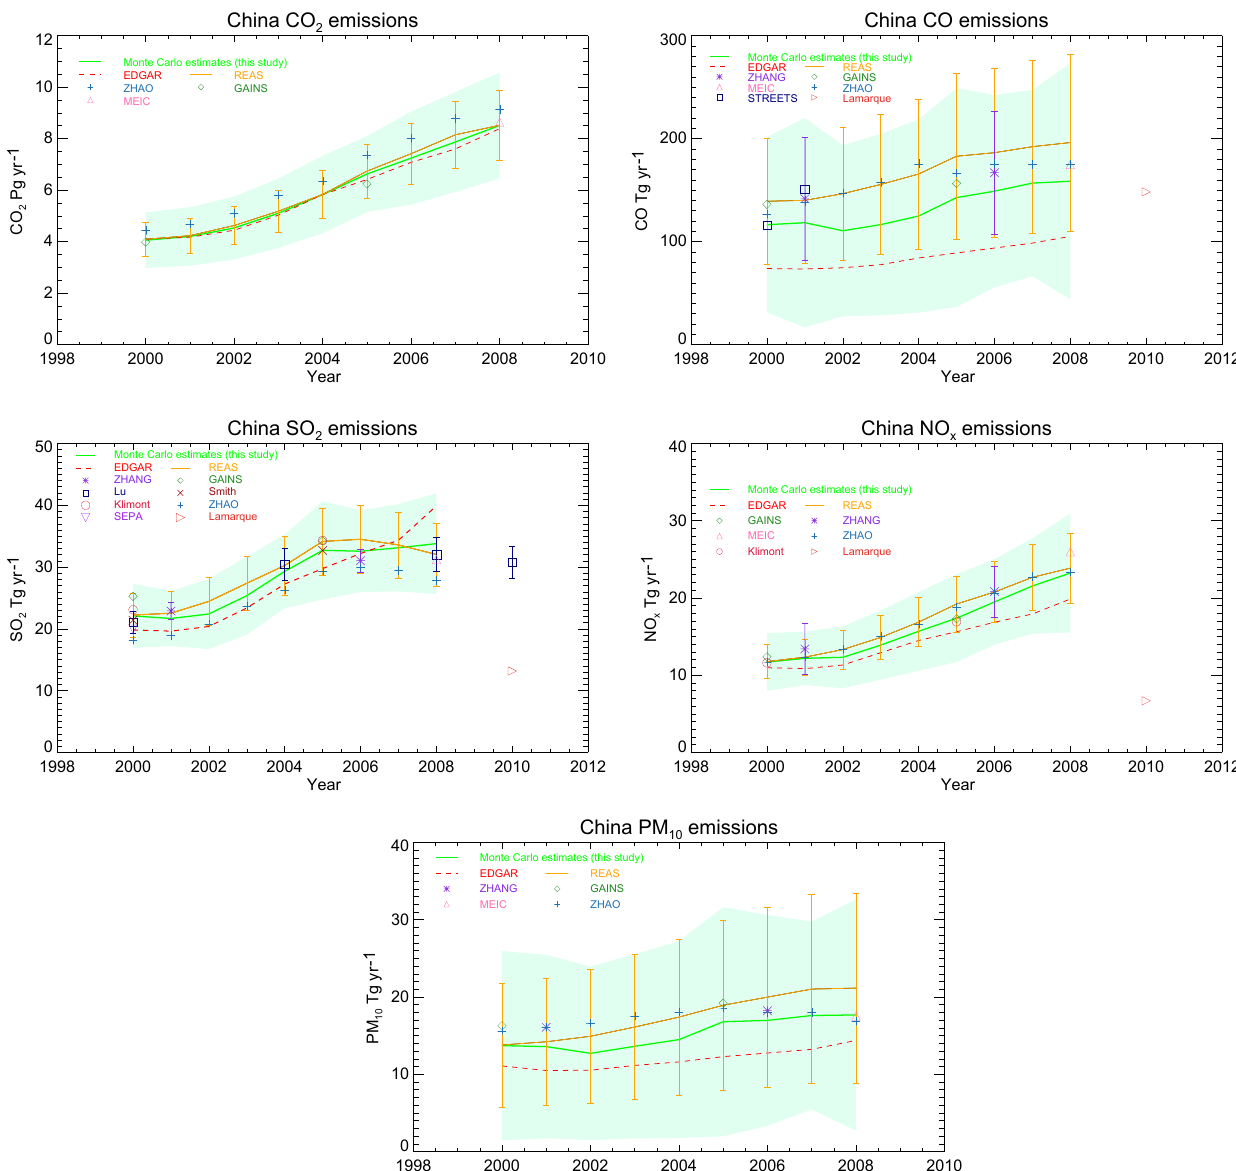
Figure 2. National total emissions estimates for CO 2 , CO, SO 2 , NO x , and PM 10 estimated by REAS, EDGAR, MEIC, ZHAO, and GAINS between 2000 and 2008, along with other existing emissions inventory estimates. Other estimates include Zhang et al. (2009), Streets et al. (2003), Lamarque et al. (2010), Lu et al. (2011), Smith et al. (2009), Klimont et al. (2013), and State Environmental Protection Administration SEPA (2000). Our Monte Carlo estimates are also included with 1 standard deviation shown as a